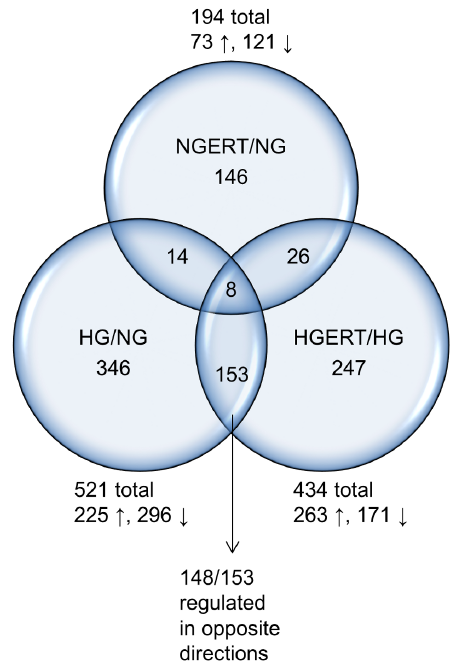
Figure 5. Venn diagram of changed transcripts. Venn diagram showing the overlap of differentially expressed transcripts after pre/co incubation with or without 5 mM erythritol (ERT) of HUVECs cultured in normal glucose (NG, 7 mM) or high glucose (HG, 30 mM) for 24 hours. Changed transcripts of the following comparisons are shown: HGERT vs HG (HGERT/HG); NGERT vs NG (NGERT/NG) and HG vs NG (HG/NG).